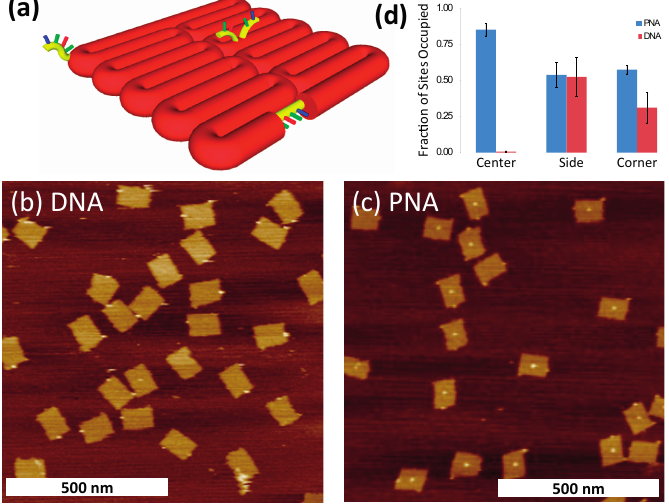
Figure 4. ( a ) Schematic drawing of modified origami displaying three different PNA3K binding sites. Orange cylinders represent DNA duplex folded into the origami. Yellow cylinders represent single-stranded DNA regions complementary to PNA3K at the three binding sites (corner, center, and side). Representative AFM images of the origami with biotinylated DNA ( b ) and biotinylated PNA ( c ); ( d ) Fraction of sites to which SA was bound for PNA (blue) or DNA (red). Each micrograph was examined and tallied individually, and the mean proportion of SA occupied sites (binding events) is displayed with error bars representing standard